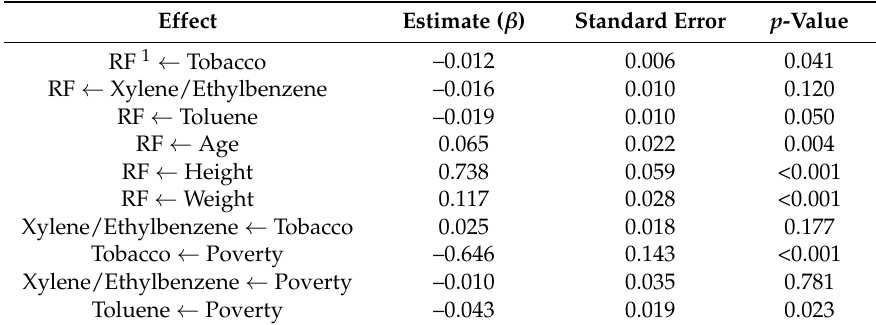
Table 3. SEM of respiratory function, tobacco smoke exposure, and VOCs: estimates, standard errors, and p -values.